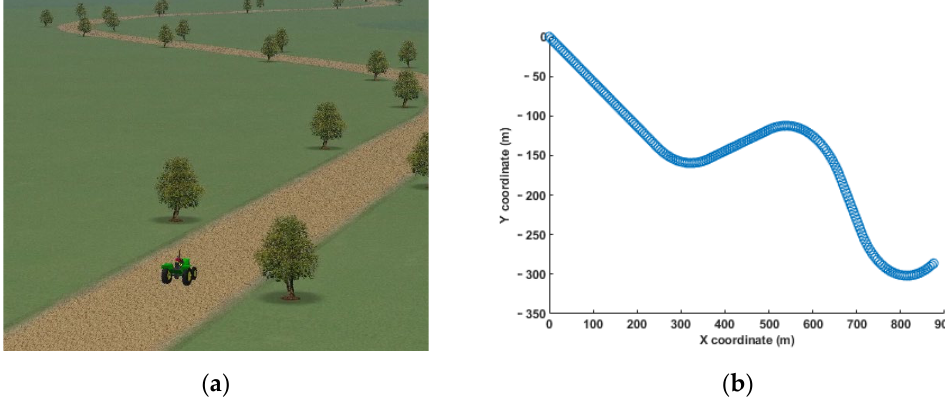
Figure 12. Driving road scenario ( a ) and coordinates ( b ).